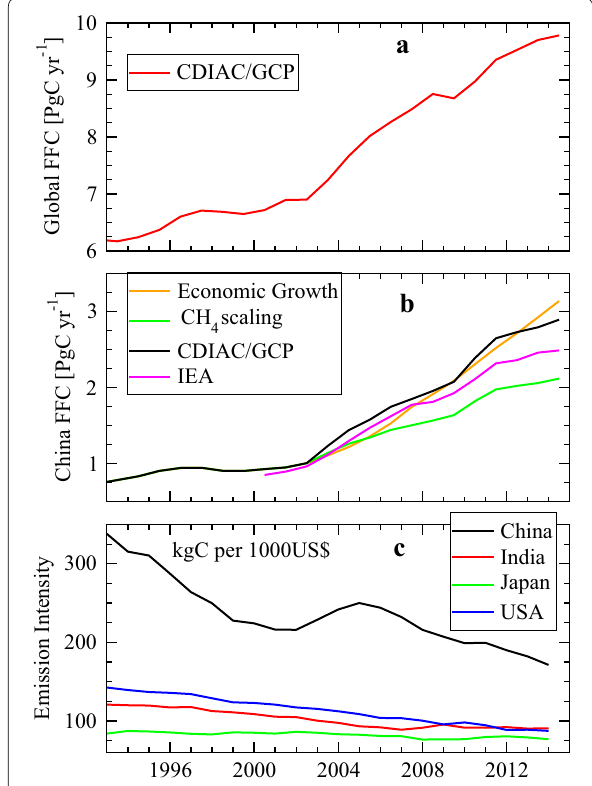
Fig. 5 Time series of global total FFC CO 2 emissions ( a ) and FFC CO 2 emission scenarios for China ( b ). Three scenarios based on a scaling factor from CH 4 inversion results for East Asia and as per the economic growth are shown in comparison with that estimated by CDIAC and IEA emission inventories. The annual emission estimates of Liu et al. (2015) agree within 4% with those estimated by IEA for ± individual years. c The emission intensity of China in comparison